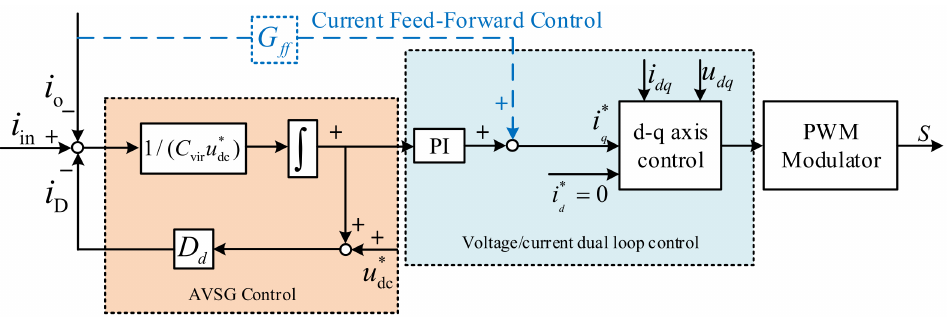
Figure 12. Control architecture for proposed AVSG in Reference